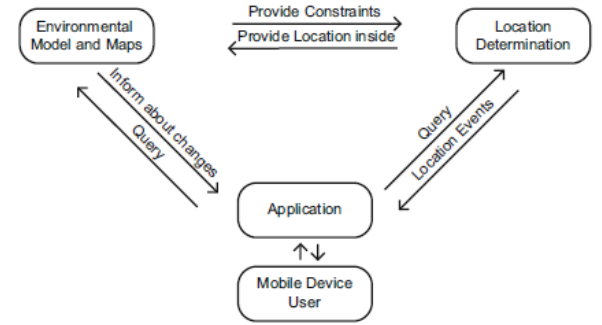
Figure 2. Building blocks of indoor location-based services (Adapted from Werner,